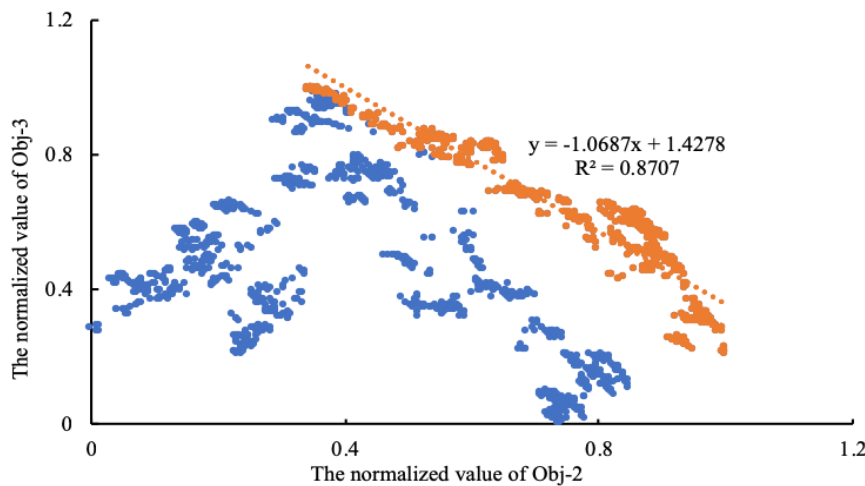
Figure 9. The two-dimensional scatter plots of Obj-2 and Obj-3’s normalized value. All the points indicate Pareto set, and among them, the orange points represent the Pareto frontier.